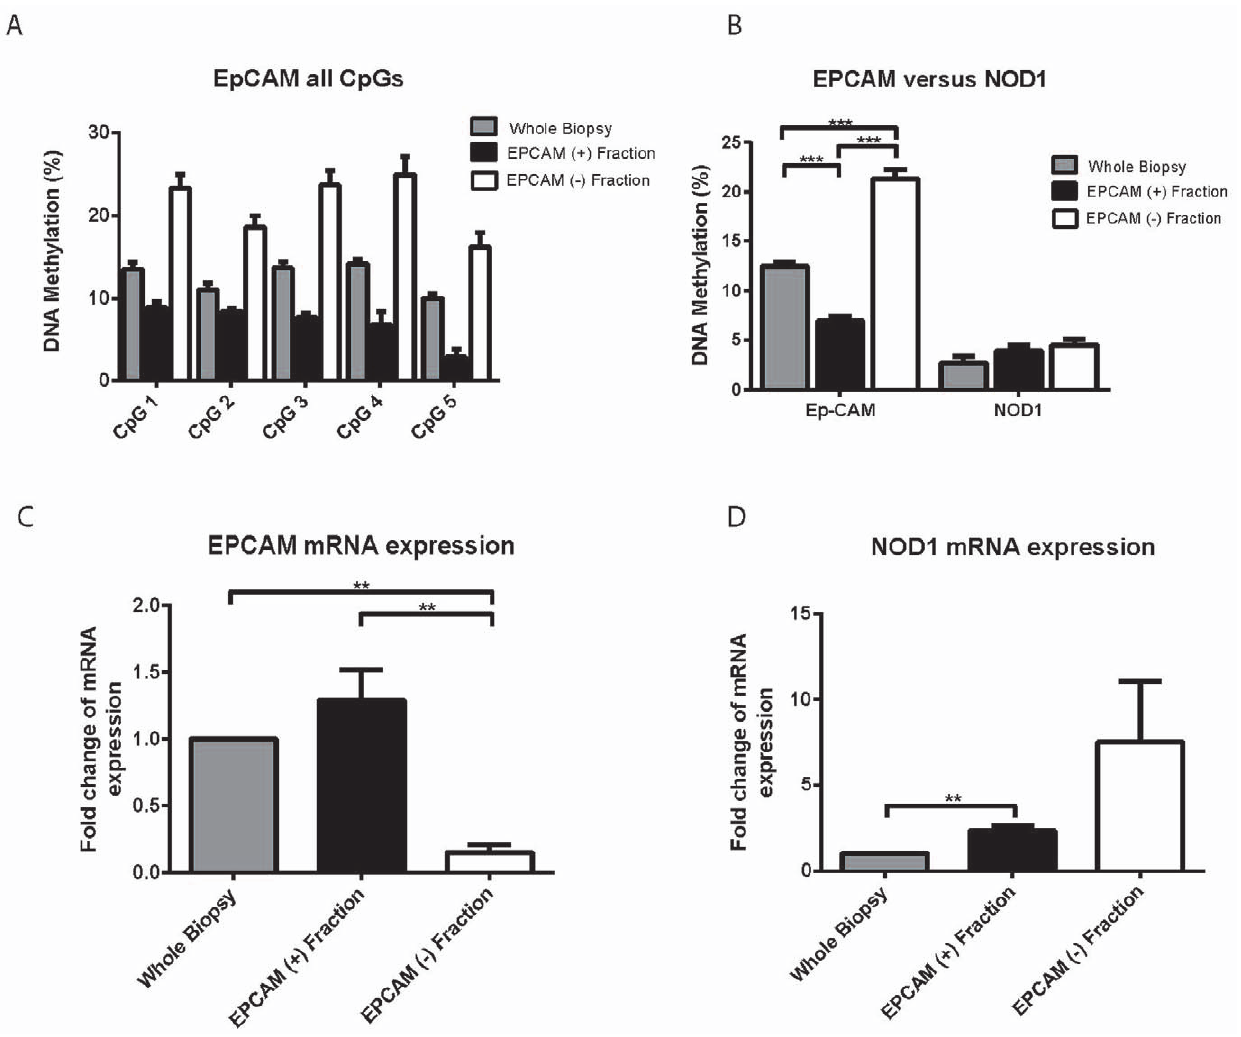
Figure 4. DNA methylation of EPCAM in whole biopsy samples compared to separated epithelium and negative cell fraction. A) DNA methylation of 5 CpGs within the EPCAM gene using a pyrosequencing assay. B) Total CpG methylation comparing EPCAM versus NOD1. Assays included 5 CpG sites for EPCAM and 2 for NOD1. C) EPCAM mRNA expression in whole biopsies compared to epithelial positive and negative separated cell fraction. Data is expressed as mean + / 2 SEM of 5 tissue samples. Differences were considered as statistically significant if p , 0.05 (** p , 0.001, ***p , 0.0001).